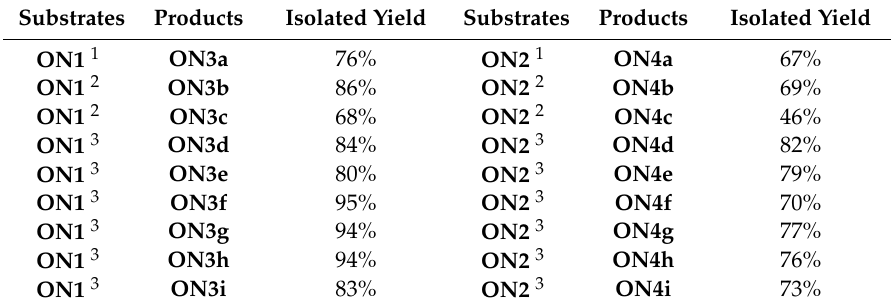
Table 1. Isolated yields of oligonucleotides containing 2 (cid:48) -urea-LNA derivatives. Substrates Products Isolated Yield Substrates Products Isolated Yield ON1 1 ON3a 76% ON2 1 ON4a 67% ON1 2 ON3b 86% ON2 2 ON4b 69% ON1 2 ON3c 68% ON2 2 ON4c 46% ON1 3 ON3d 84% ON2 3 ON4d 82% ON1 3 ON3e 80% ON2 3 ON4e 79% ON1 3 ON3f 95% ON2 3 ON4f 70% ON1 3 ON3g 94% ON2 3 ON4g 77% ON1 3 ON3h 94% ON2 3 ON4h 76% ON1 3 ON3i 83% ON2 3 ON4i 73%